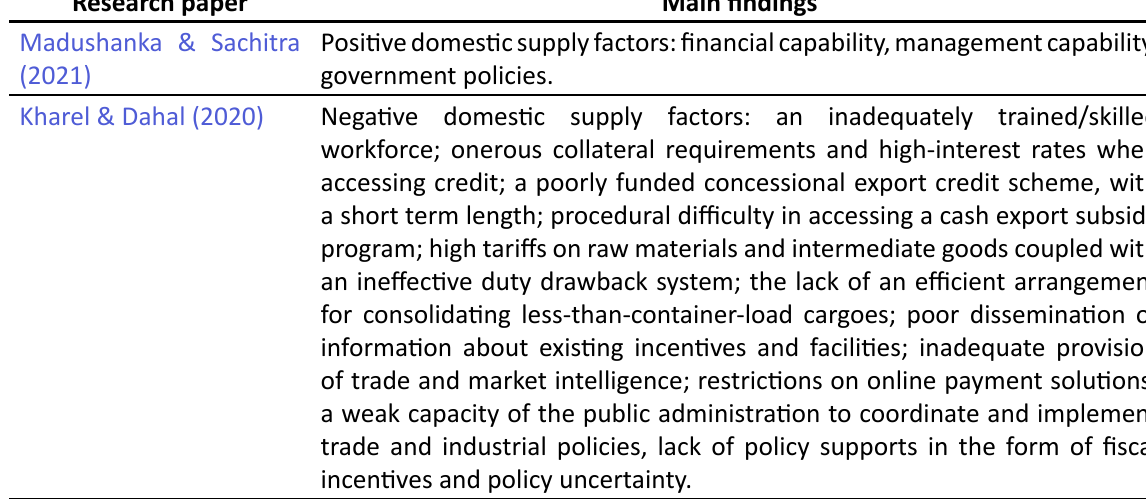
Table 2: Main Findings from Selected Important Research Papers on Determinants of MSMEs’ ability to do Direct Export Main